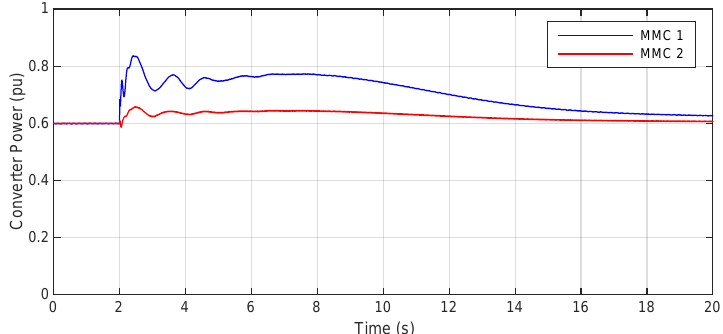
Figure 16. Power injected by the HVDC converter terminals after the disturbance in Scenario